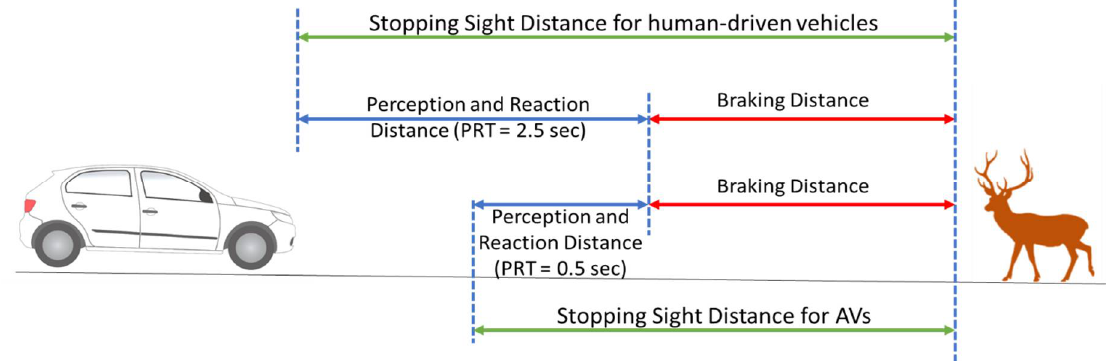
Table 1. SSD on level roads for human-driven vehicles and autonomous vehicles (AVs).